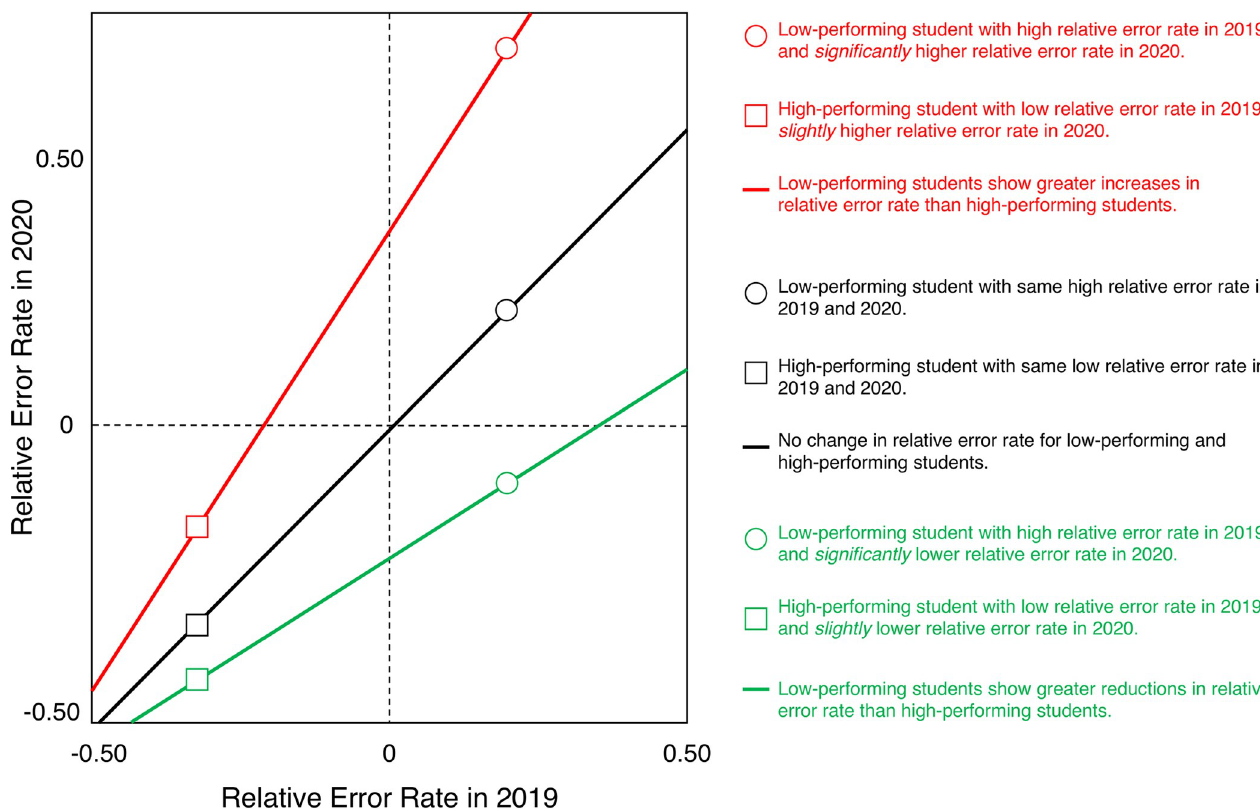
Fig 2. Hypothetical regression analysis of relative performance. Students’ relative error rate in 2020 (ordinate) is regressed against their relative error rate in 2019 (abscissa). Three different hypothetical outcomes are illustrated in red, black and green (see legend and text).